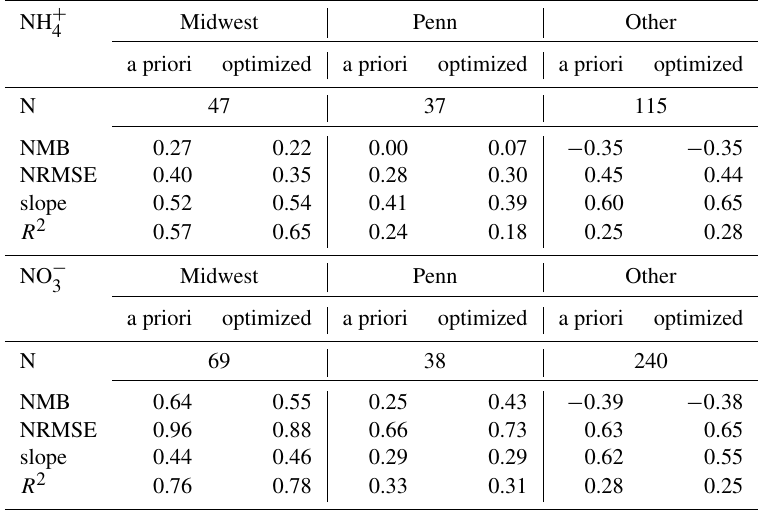
Table 1. Statistical summary of the correlation between simulated monthly average NH + April ∗ .